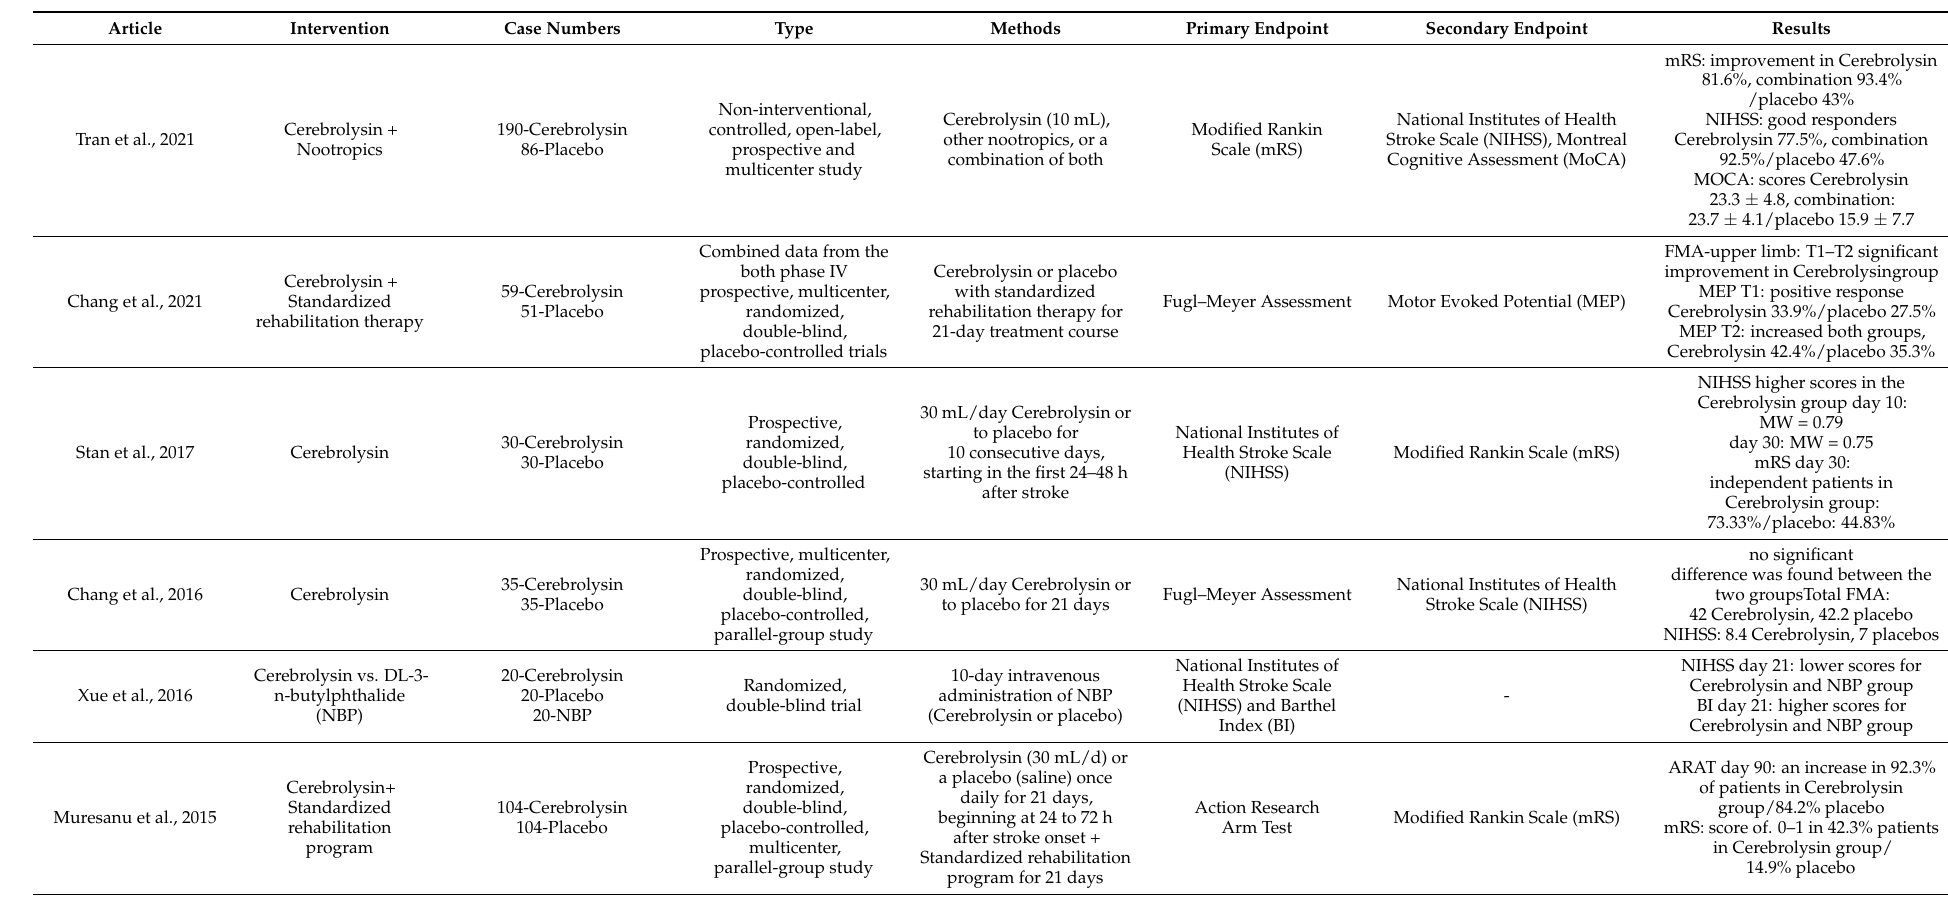
Table 1. Trials involving the effect of Cerebrolysin on acute ischemic stroke in the past 9